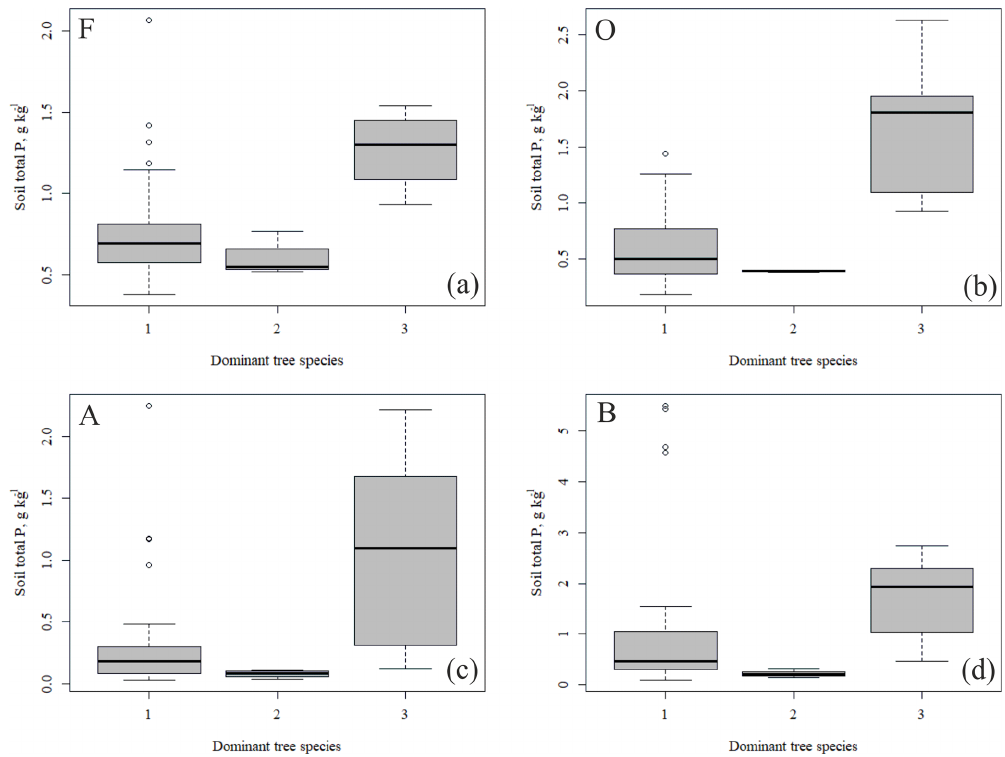
Figure 3. Soil total phosphorus (P) contents of the research plots (based on dominant tree species) in different soil horizons. Species 1 = pine, 2 = spruce and 3 =